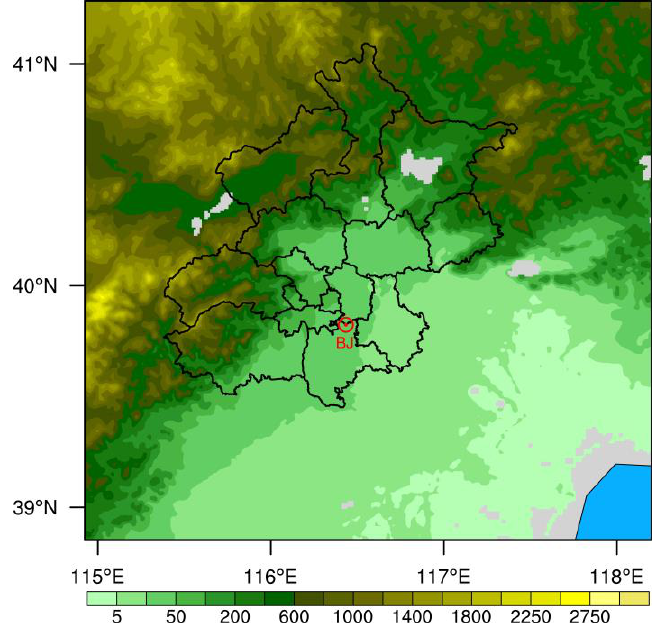
Figure 1. Topographic (m) information around the PARSIVEL 2 disdrometer site at Beijing station (BJ, the red circle). The districts of Beijing are highlighted in black curves.